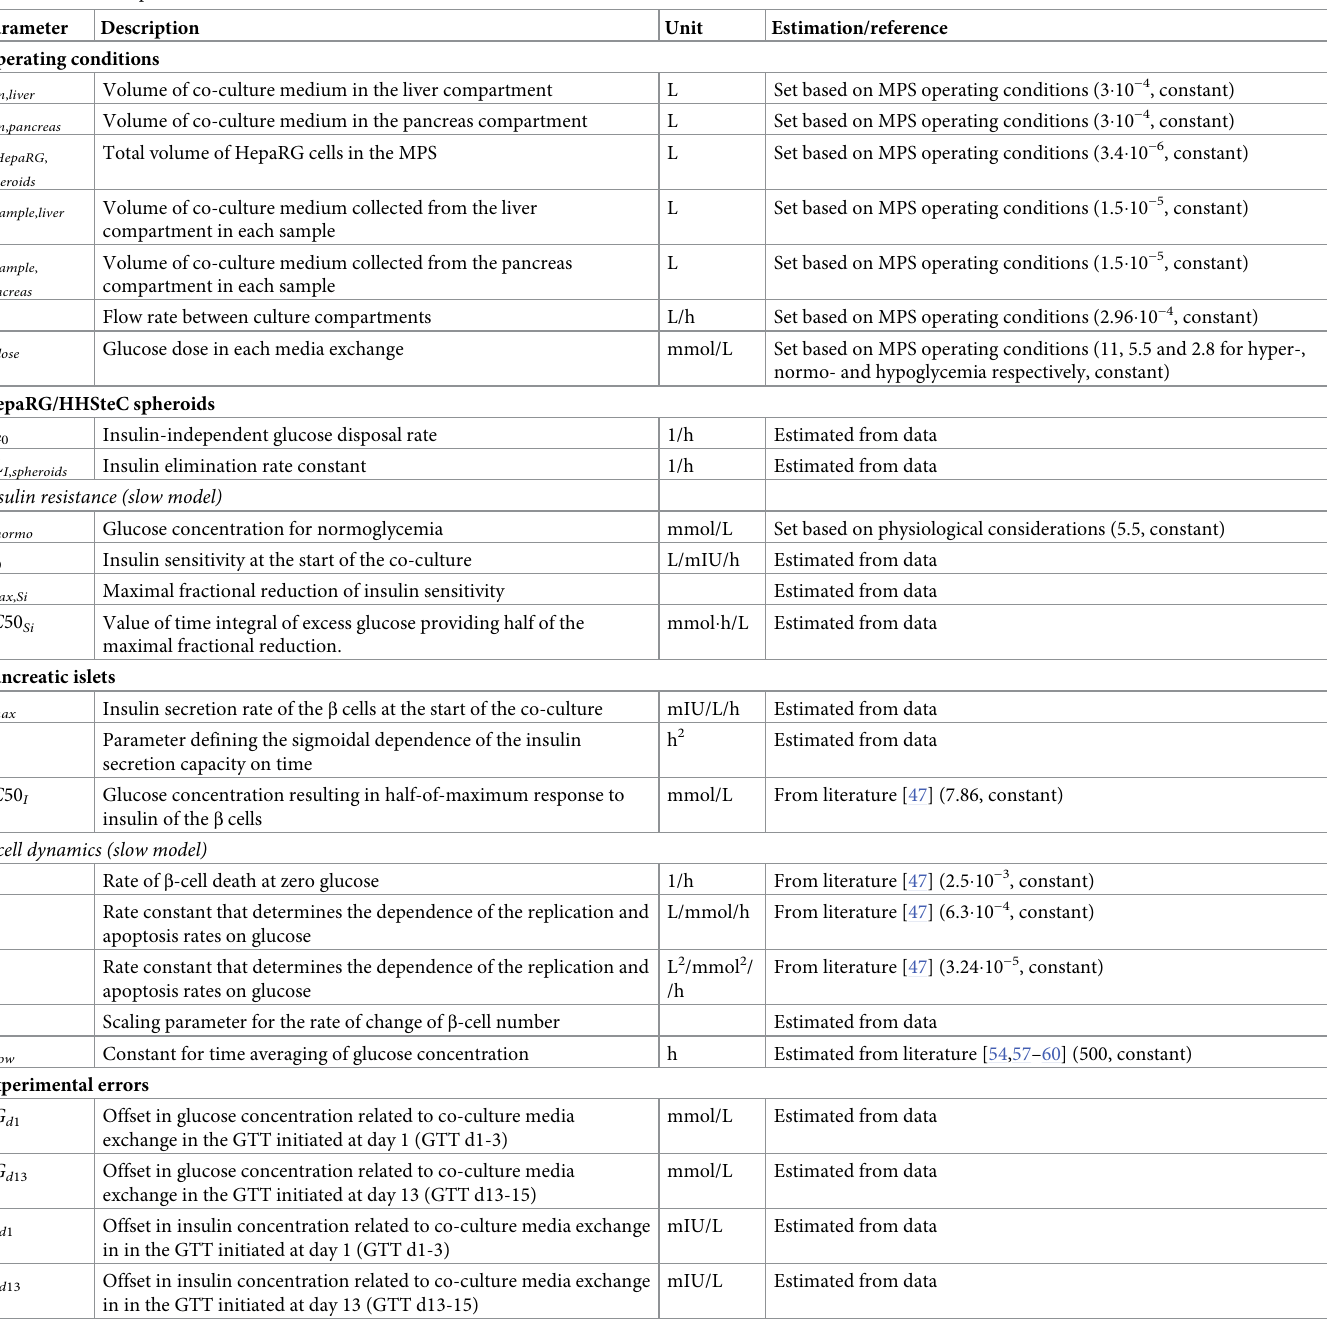
Table 1. Parameters in the computational model. Parameters specified as constant were not included in the parameter estimation routine. The estimated parameter val- ues for each MPS experiment are listed in S3